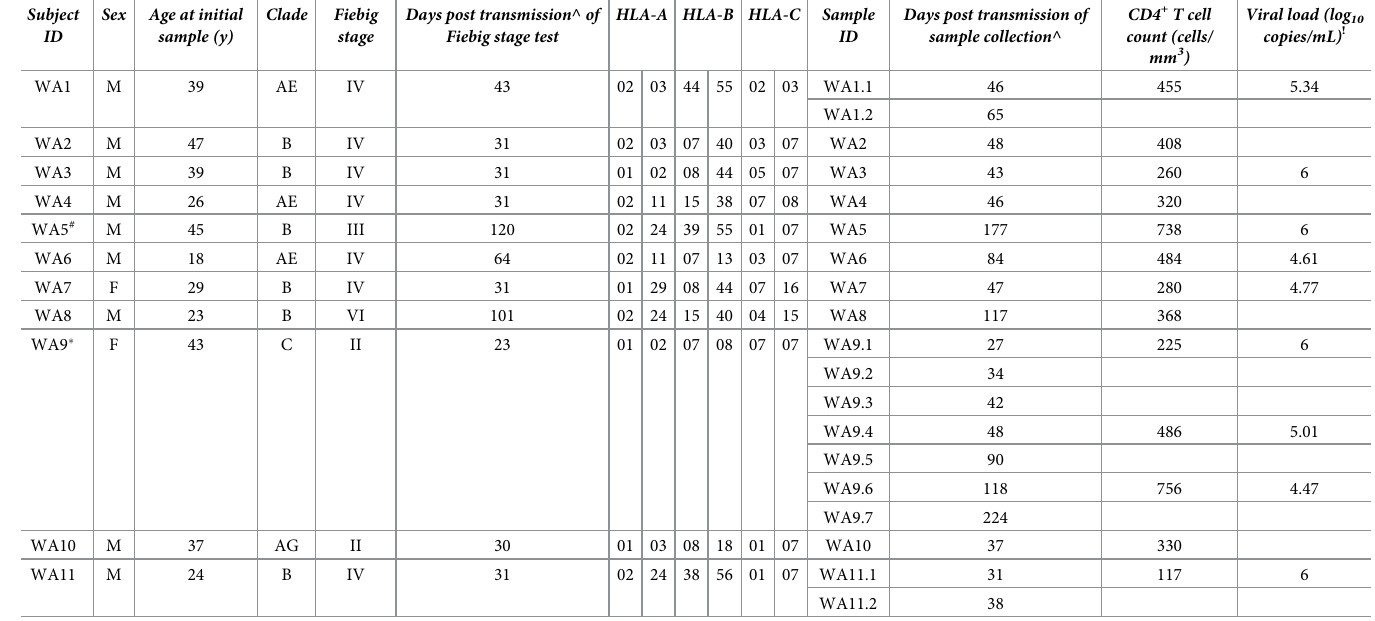
Table 1. Clinical and immunogenetic characteristics of the acute WA